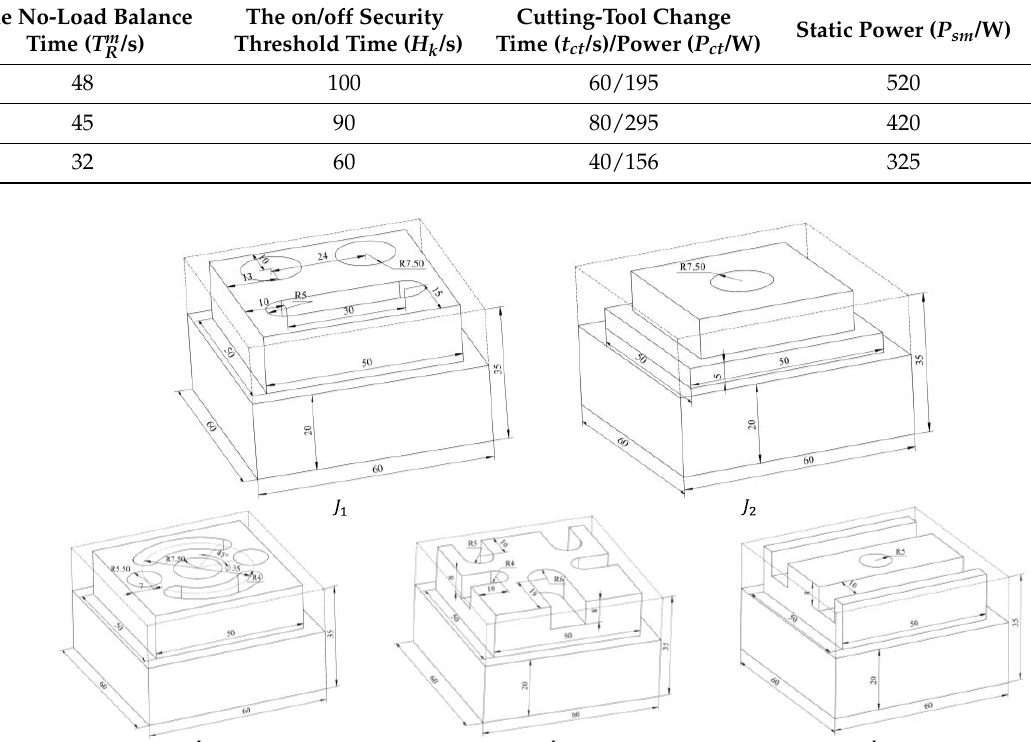
Figure 19. Three-dimensional model drawing of the five workpieces.